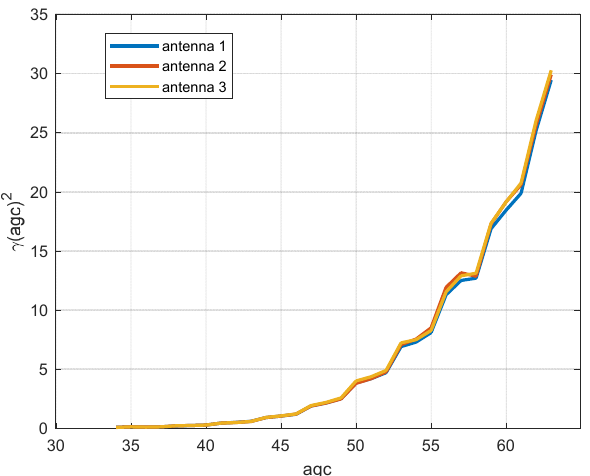
( ) 2 agc γ and agc . Figure 2. The relationship between γ 2 ( agc ) and agc